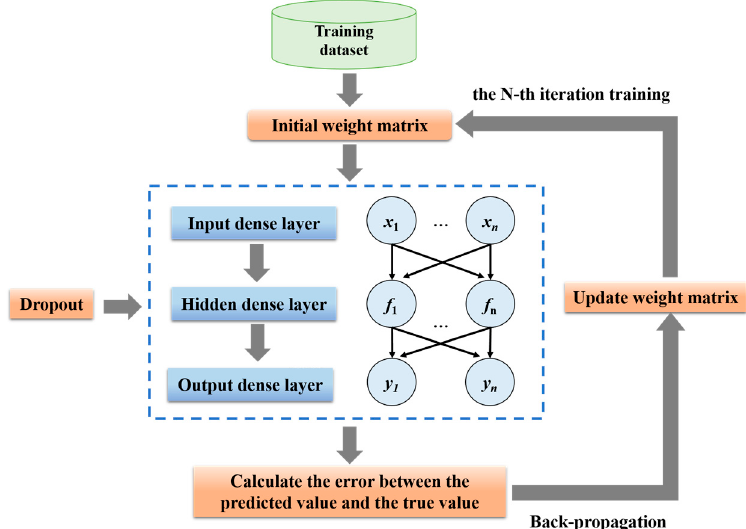
Figure 1. Schematic Diagram of the DNN Training Process.